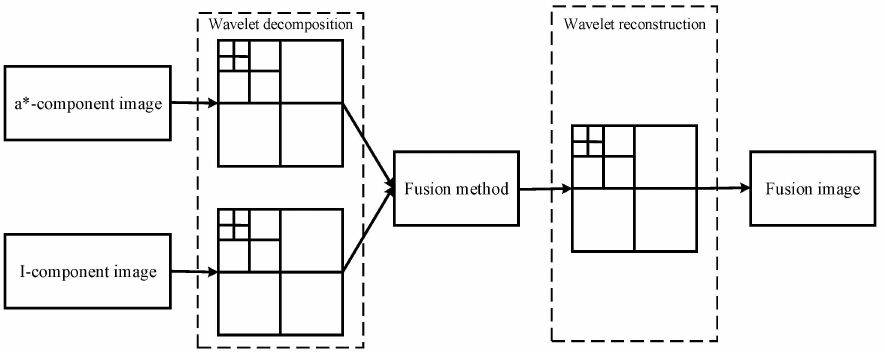
Figure 1. Strategy of image fusion based on wavelet